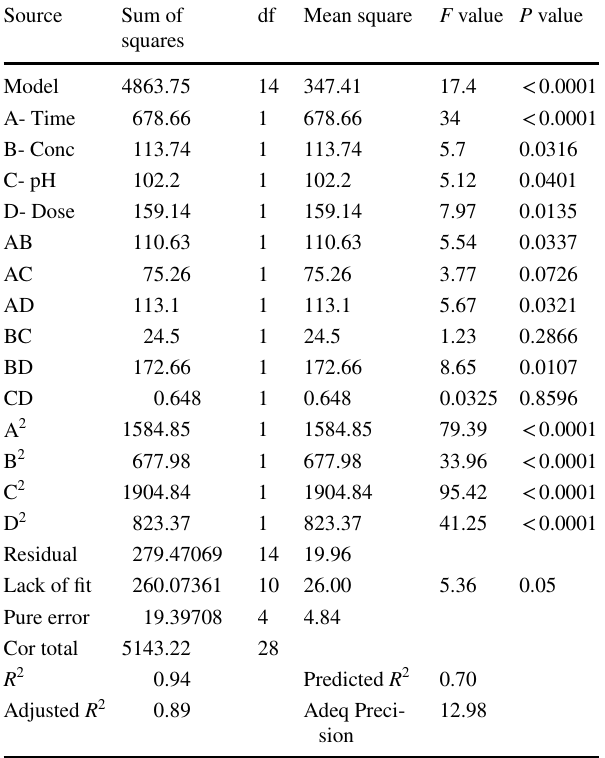
Table 6 Analysis of variance (ANOVA) for quadratic model of MNZ removal by S. platensis Source Sum of